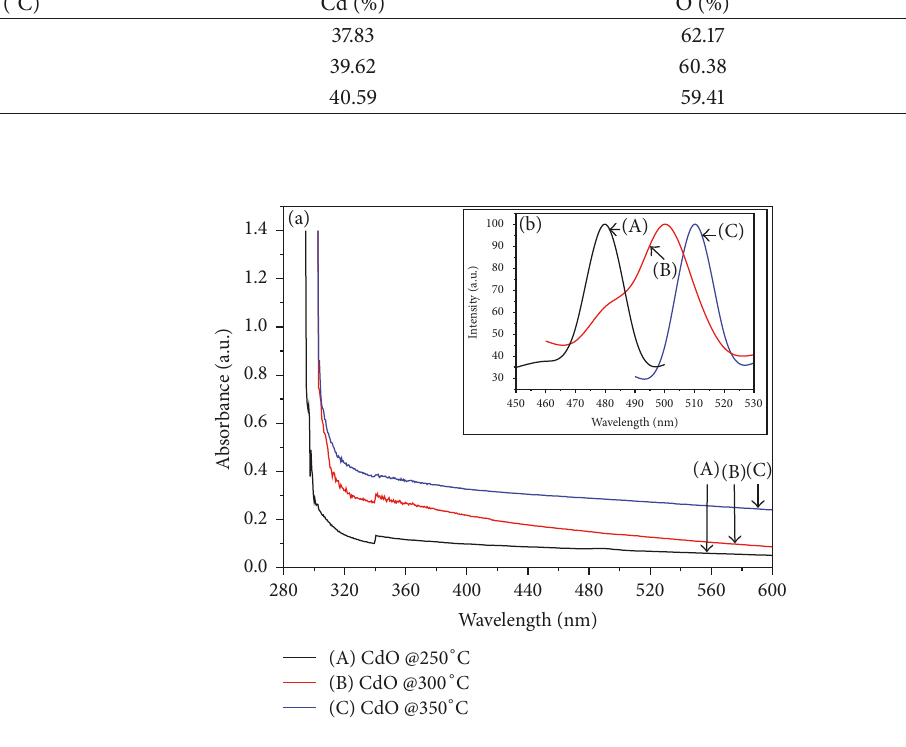
Figure 5: Absorption (a) and emission (b) spectra of CdO thin films prepared at 250 (A), 300 (B), and 350 ∘ C